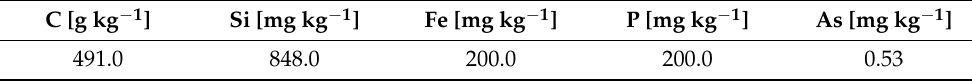
Table 1. Chemical composition of the Vechtaer Moor peat material used in